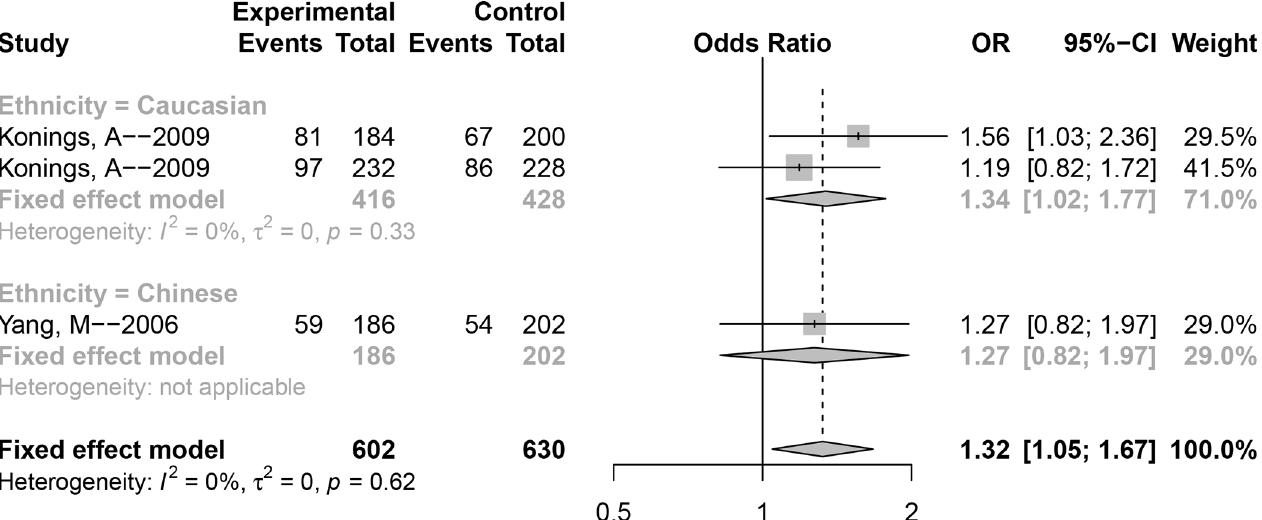
Fig 3. Forest plot of the association between polymorphism rs1061581 and noise-induced hearing loss (NIHL) (Allele model: G versus A).